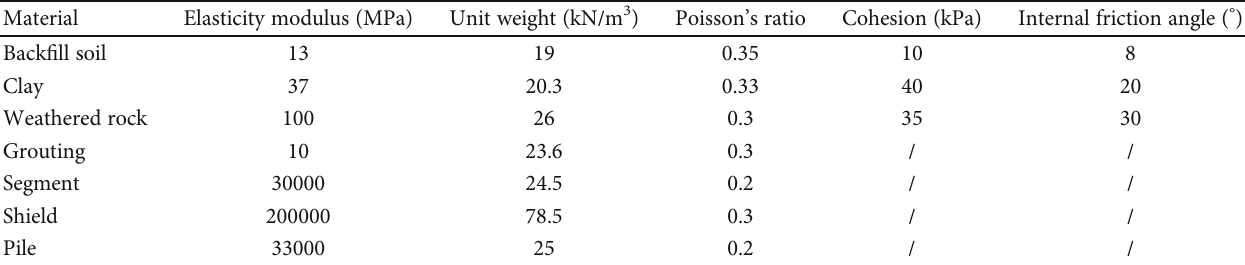
Figure 4: Meshing of numerical models. Table 2: Material parameters for numerical